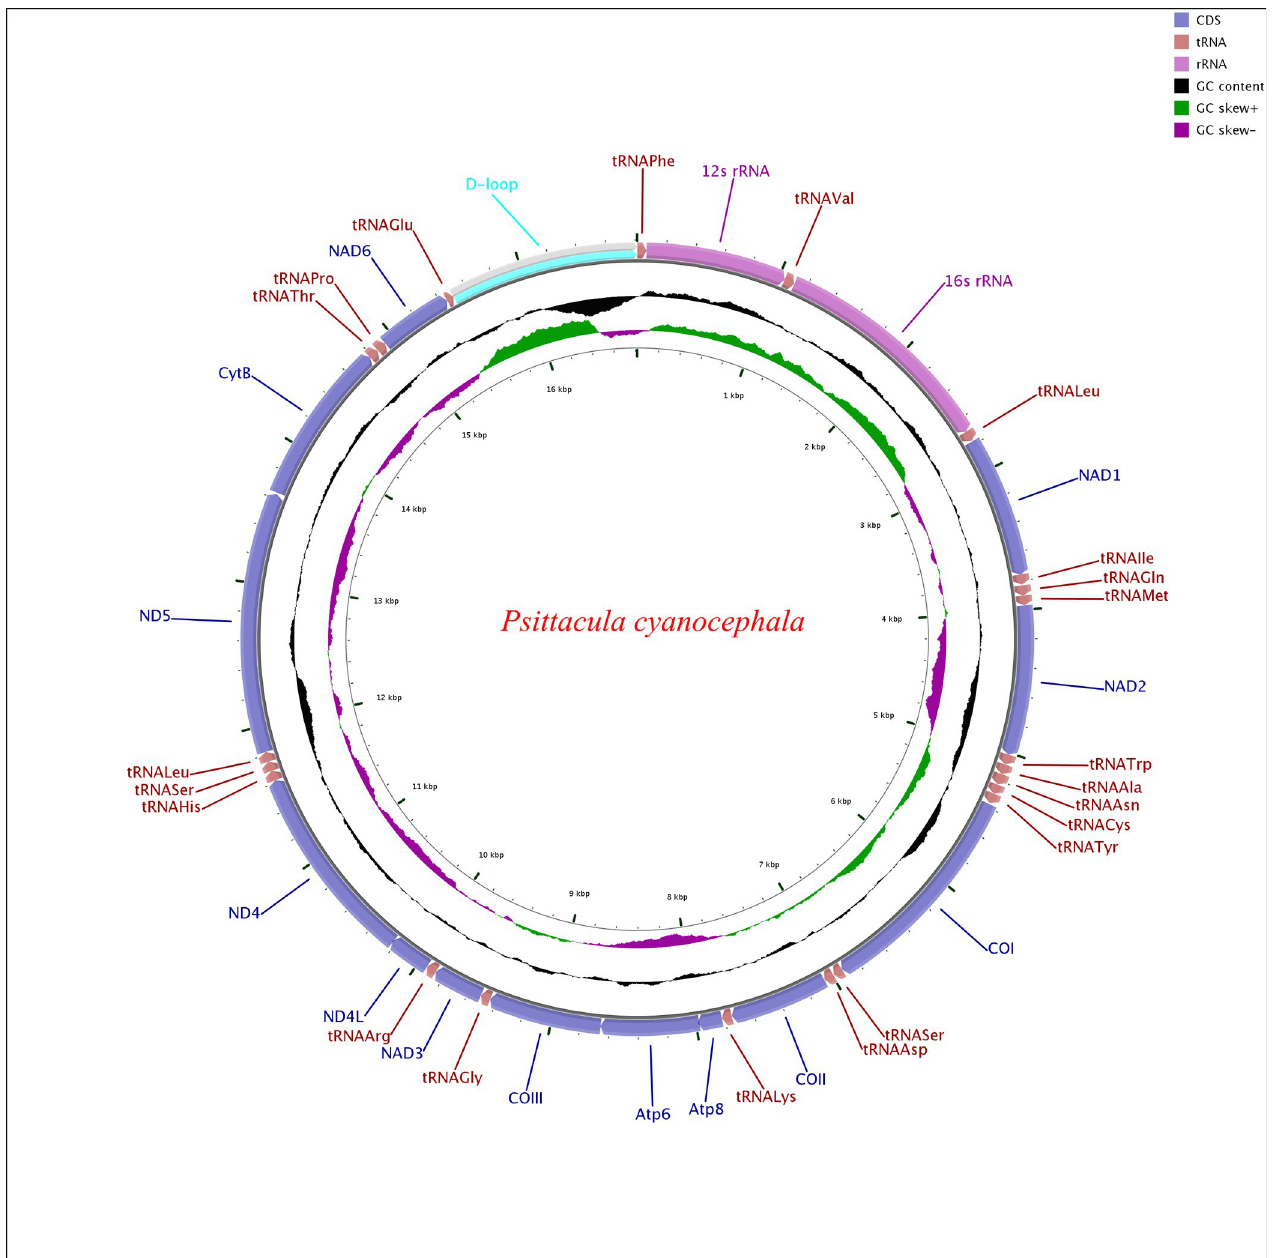
Fig 1. Circular map of the Psittacula cyanocephala mitochondrial genome. Various genes are represented with different colour blocks. Gene transcription direction is indicated by arrows. Colour codes and legends are displayed at the upper right side of the figure. Black sliding window indicated the GC content of all the regions and GC skew through green and violet colour sliding windows. The figure was drawn by CGView Online server (http://stothard.afns.ualberta.ca/ cgview_server/) and edited in PaintDotnet tool. a C3 bias at codons’ third position. The amino acid usage-based heatmap along with roseplot of amino acid of P . cyanocephala (Figs 2C and 3B) showed Leucine, Isoleucine, Proline, Serine and Threonine were dominant than other amino acids in the mitogenome of P . cyanocephala . The effective number of codons (ENc) using plot analysis (Fig 2E), revealed that all the